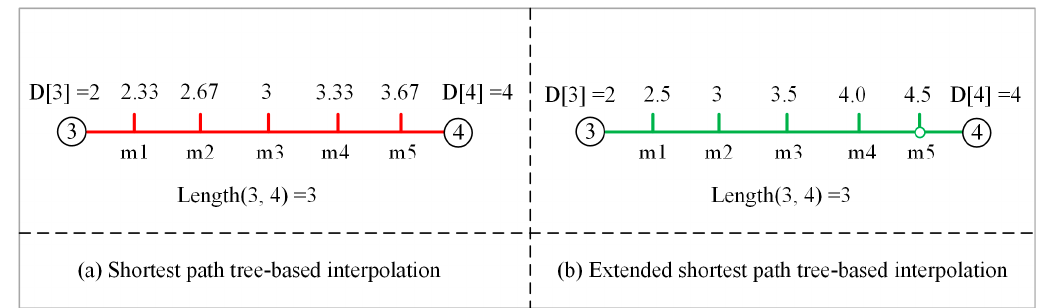
Figure 5. Illustration of the interpolations based on the shortest ( a ) and extended shortest path trees ( b ). In the context of the TCA generation, the root node of the extended SP tree is set to be the projected (cid:48) point p . The network corresponds to the subgraph G p of the facility p . By following the above three steps, an extended SP tree can be generated for each subgraph.